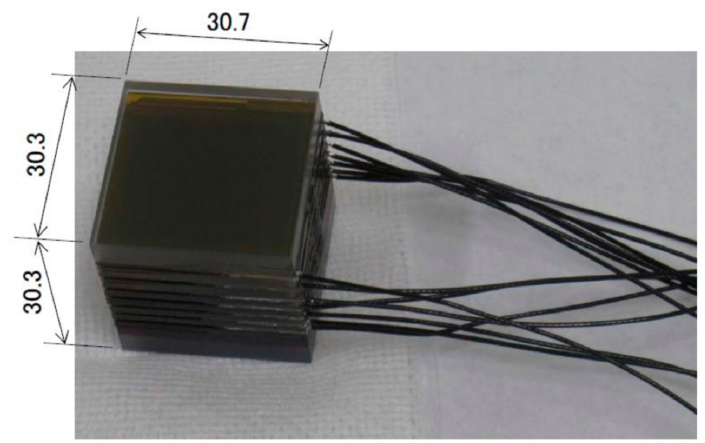
Figure 4. Photograph of the liquid crystal tunable filter (LCTF) (unit: mm).